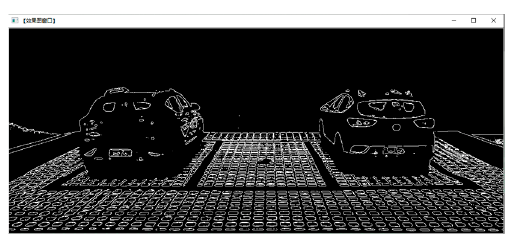
Figure 18. Gamma-enhanced image.